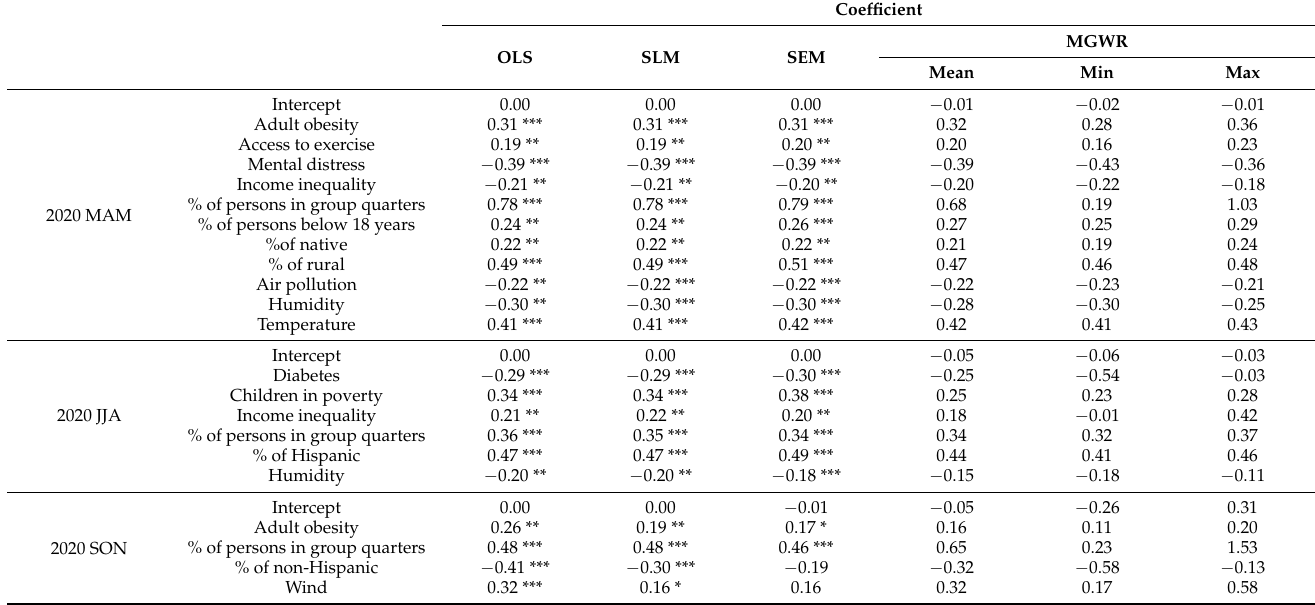
Table 5. Coefficients of each health, socioeconomic, demographic, and environmental factor from the OLS, SLM, SEM, and MGWR models for each season from 2020 to